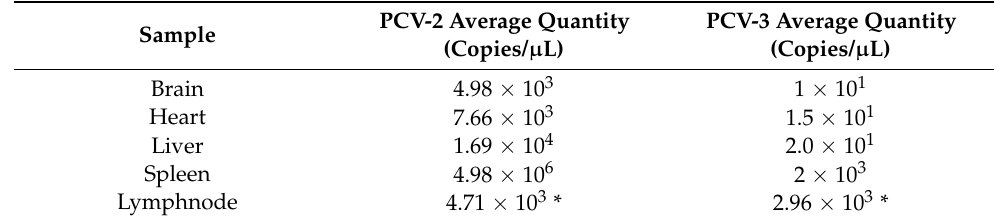
Table 4. Average number of PCV-2 or PCV-3 genomes (copies/ µ L) found in the different wild boar organs, analyzed by real-time quantitative